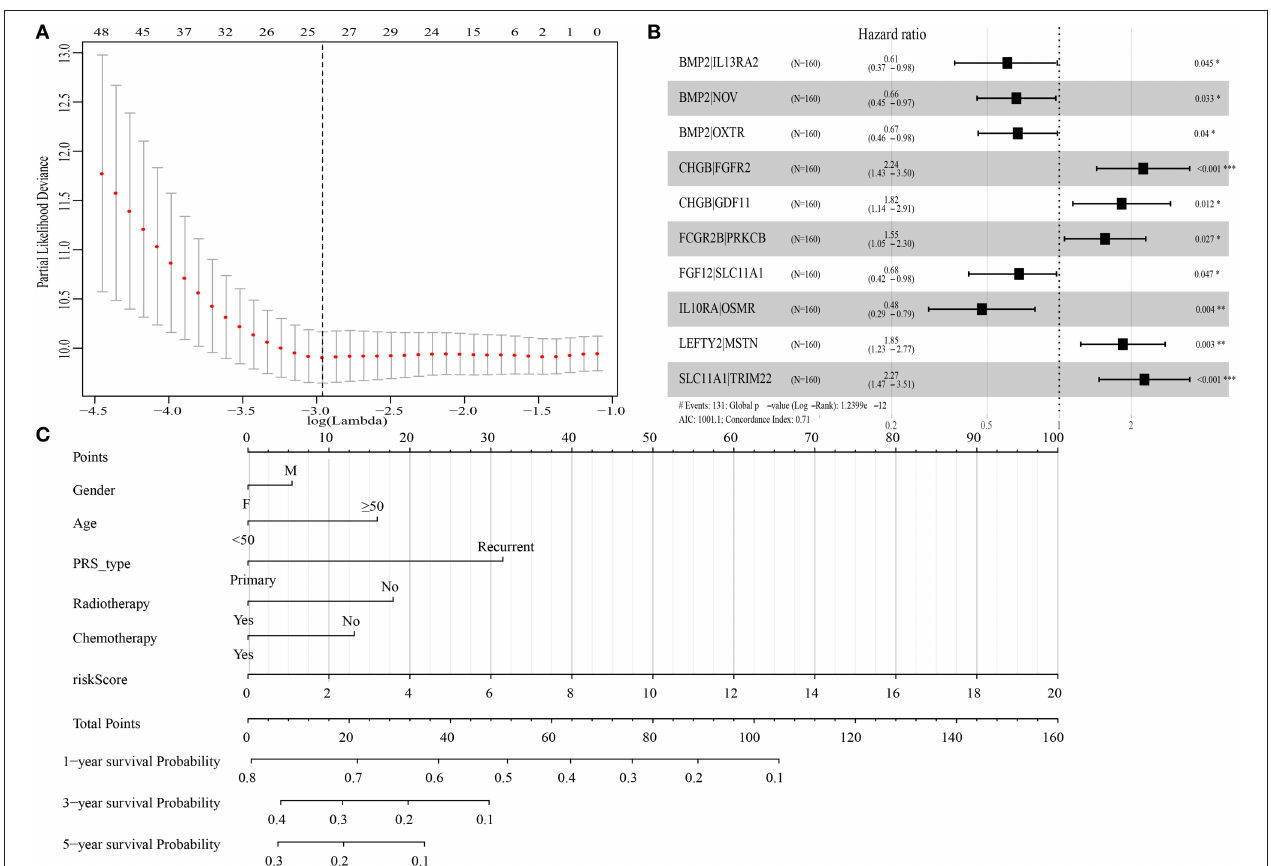
FIGURE 1 | Construction of immune-related gene pairs (IRGPs) signature. (A) “Leave-one-out-cross-validation” for the parameter selection in the least absolute shrinkage and selection operator (LASSO) regression. (B) The forest map of multivariate Cox regression analysis. (C) The prognostic nomogram for the prediction of